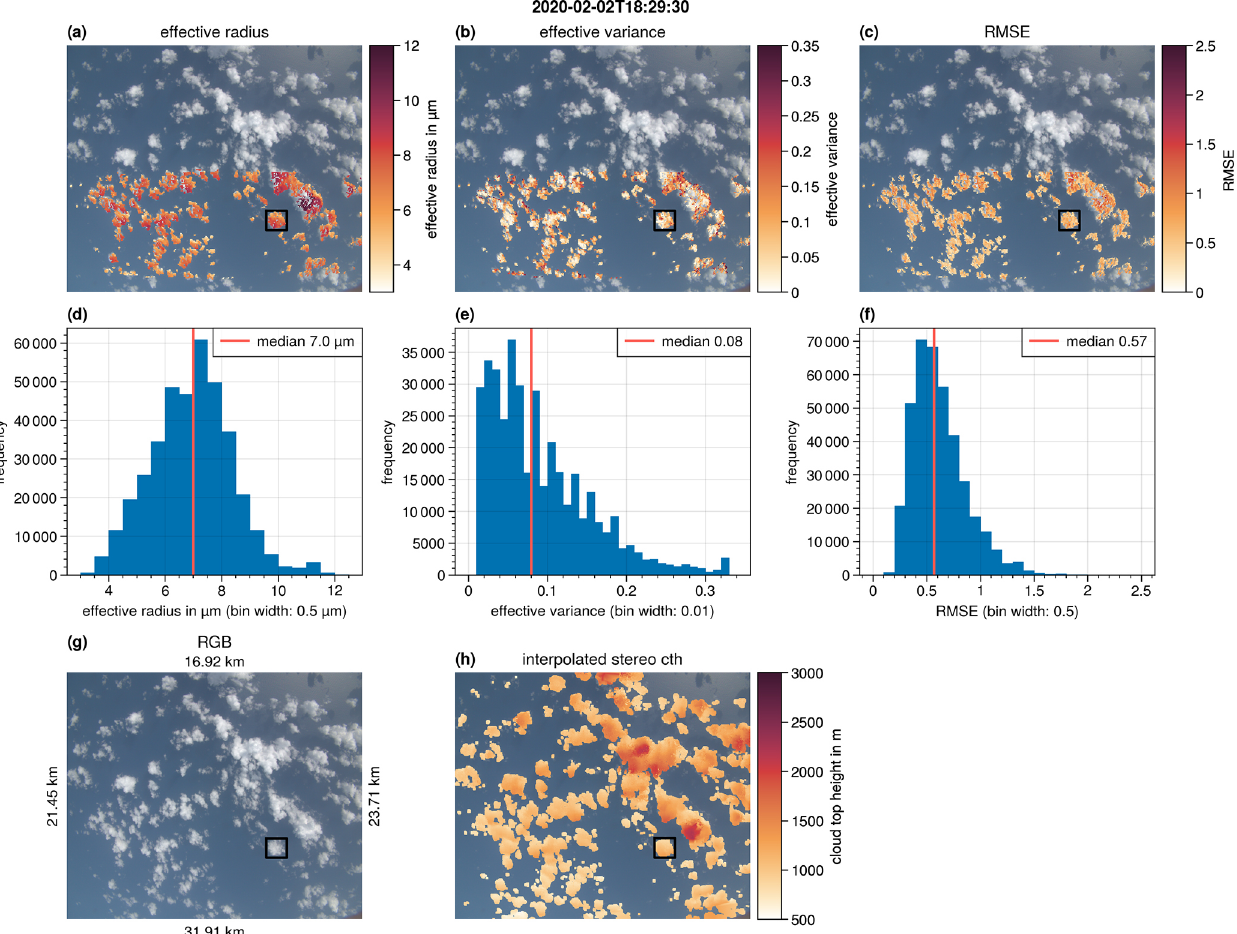
Figure 12. Same as in Fig. 7 but for case study 2 presented in Fig. 10. The black rectangle marks a single cloud that is presented in Fig. 14.